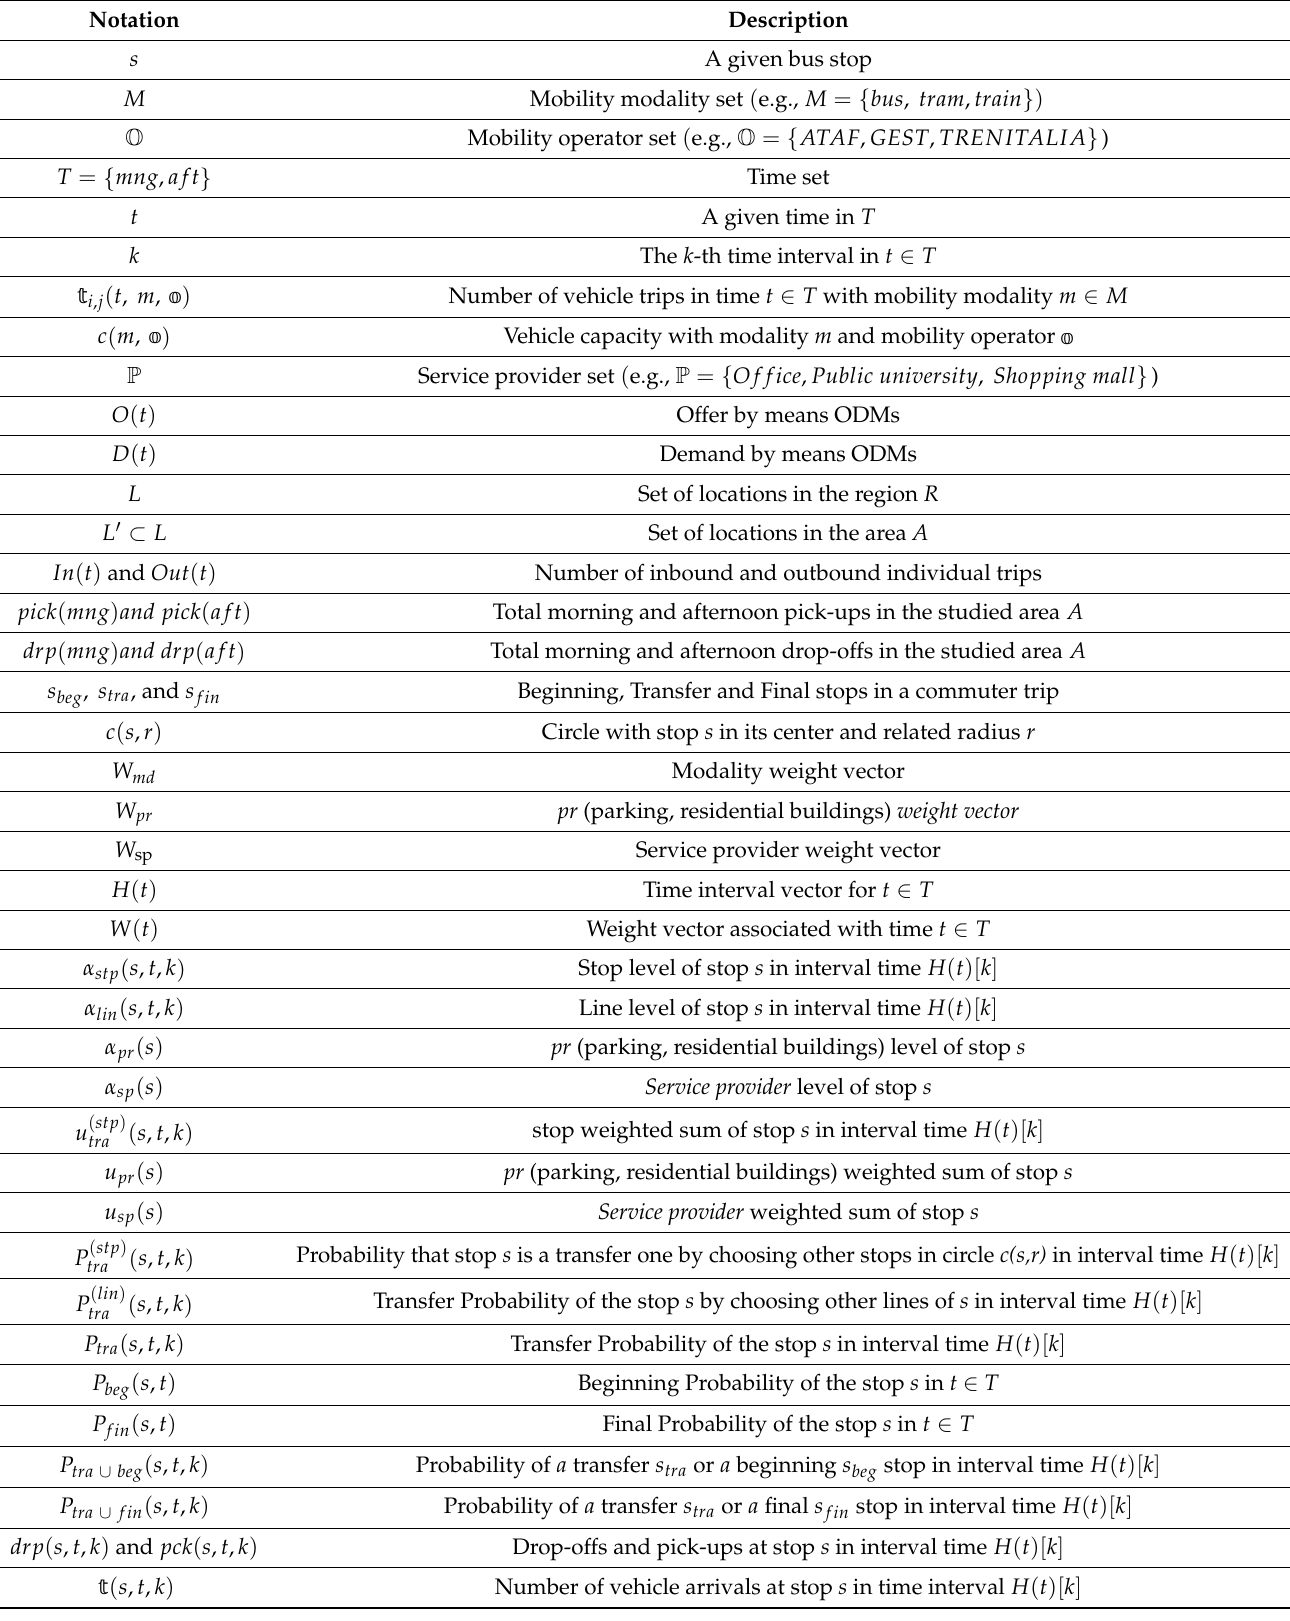
Table 2. Main formal notations.